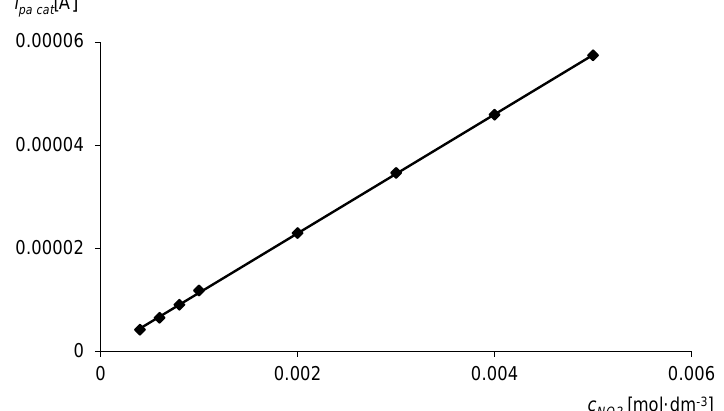
Figure 6. Plots of i pa NO 2 − catalysis ( i pa cat ) vs. NO 2 − concentration at Pt poly [Ni(salcn)] (after electropolymerization: 3 scans, v = 0.05 V s – 1 ). Data from Figure S6.